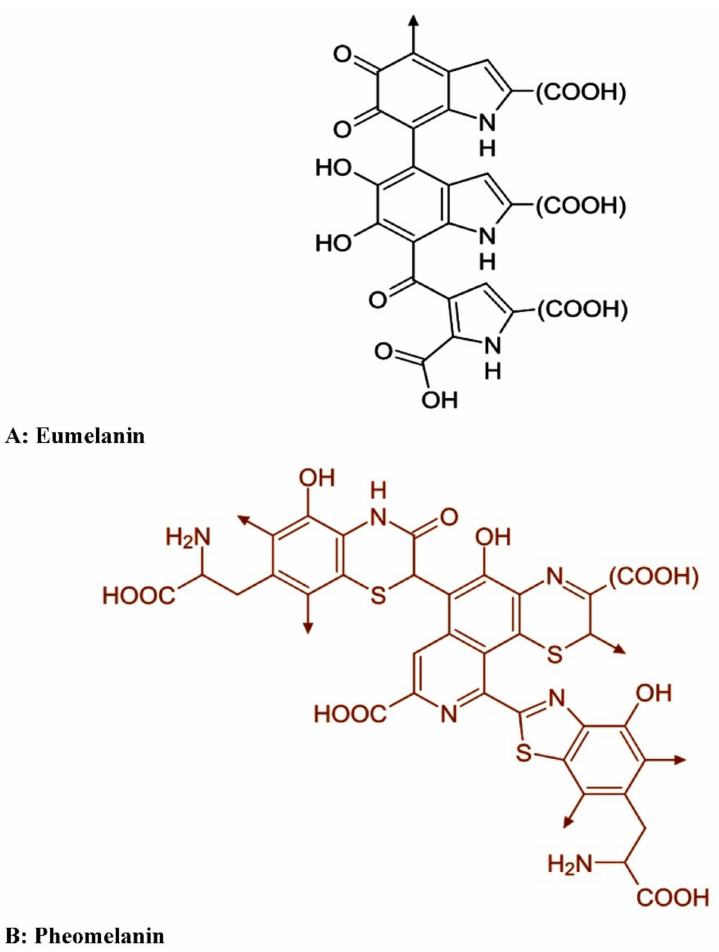
Figure 3. Part of the structural formula of the most common types of melanins; eumelanin ( A ), and pheomelanin ( B